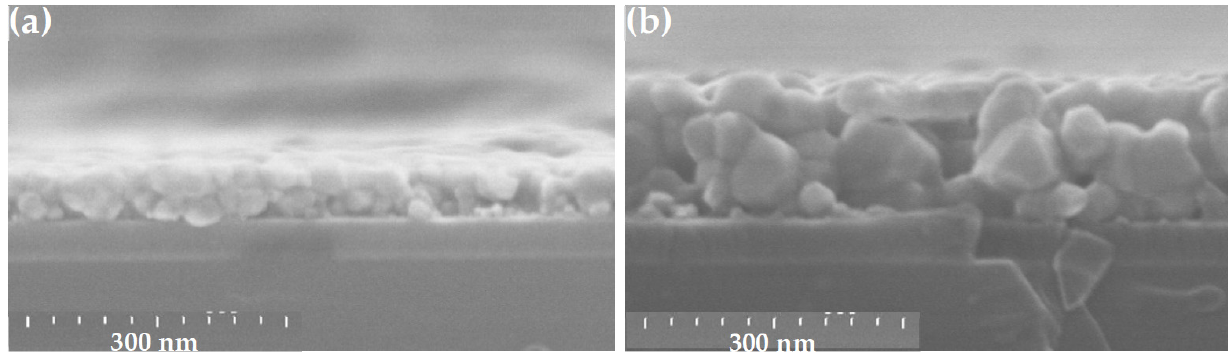
Figure 3. Cross-sectional SEM views of sol-gel spin-coated ZnO samples obtained with [ZnAc] = 0.25 mol/L ( a ) and 1.00 mol/L ( b ), respectively.